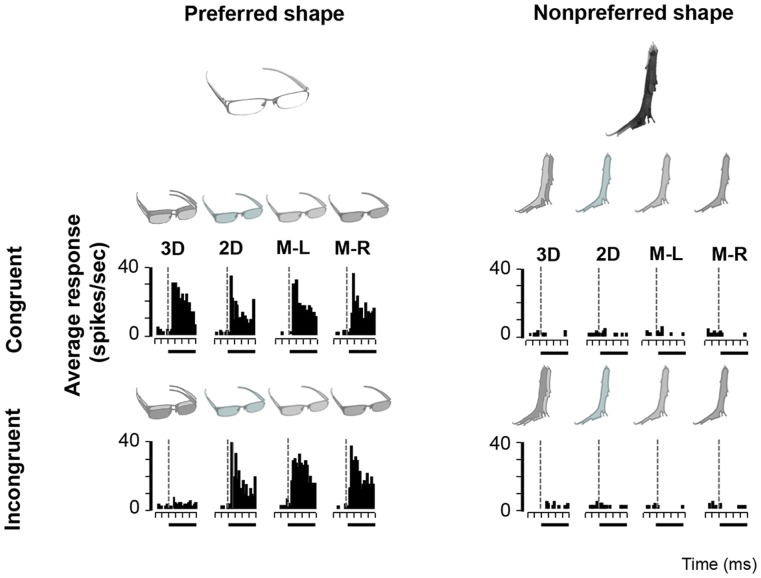
Disparity- and contour-selective example neuron.This neuron also preferred congruent over incongruent stereo stimuli (left), but remained image selective in the absence of disparity (compare the responses to the 2D image of the glasses with those of the vertical branch).